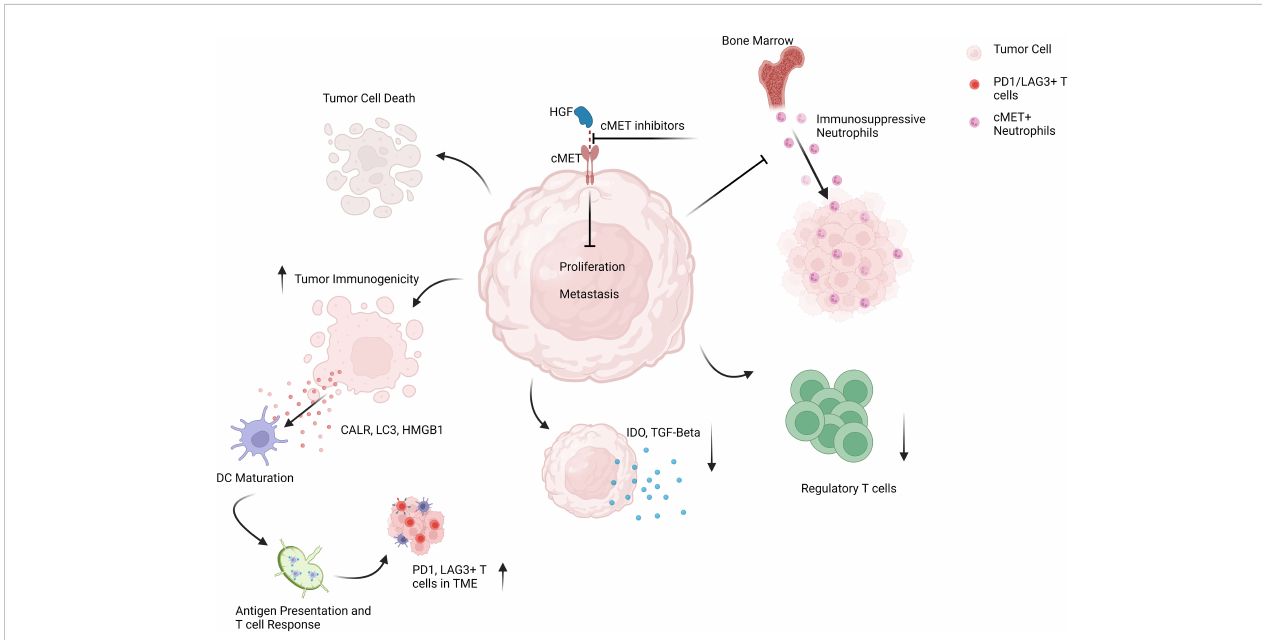
FIGURE 2 Schematic representation of targeting cMET pathway in mUM patients to enhance the anti-tumor ef fi cacy of ICI